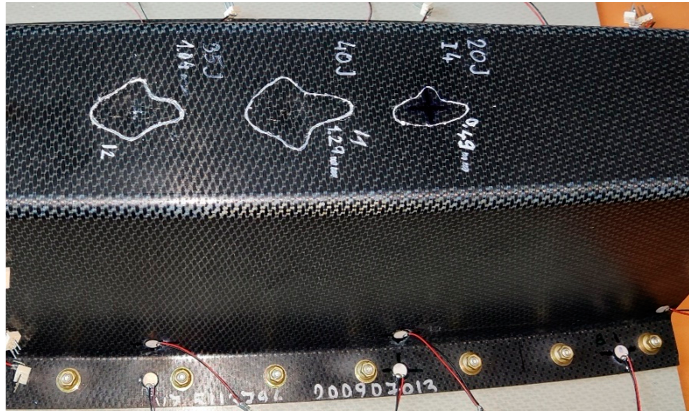
Figure 11. Small panel with damage from three impacts.